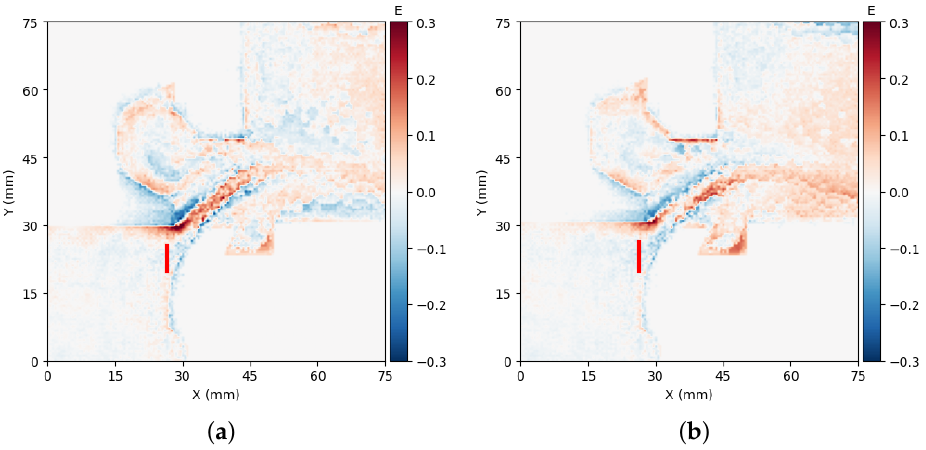
Figure 16. Comparison of error for different spool displacement: ( a ) h = 10 mm; ( b ) h = 11